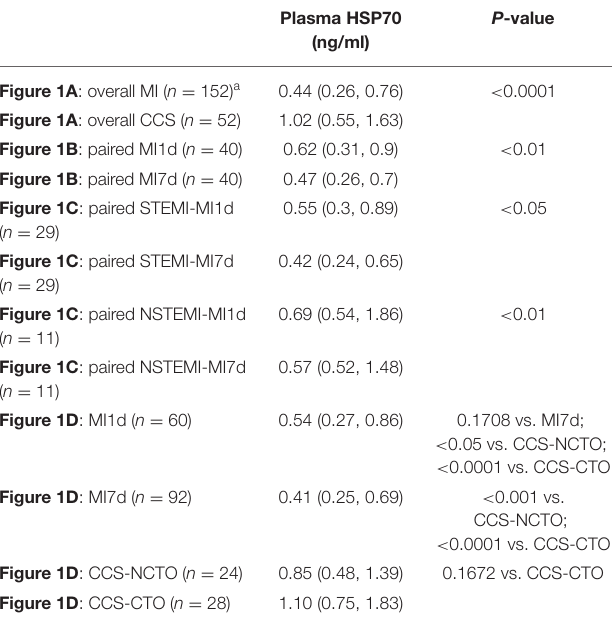
P -value Plasma HSP70 (ng/ml) 0.55 (0.3, 0.89) < 0.05 0.42 (0.24, 0.65) 0.69 (0.54, 1.86) < 0.01 0.57 (0.52, 1.48) < 0.05 vs. CCS-NCTO; < 0.0001 vs. CCS-CTO CCS-NCTO; < 0.0001 vs. CCS-CTO